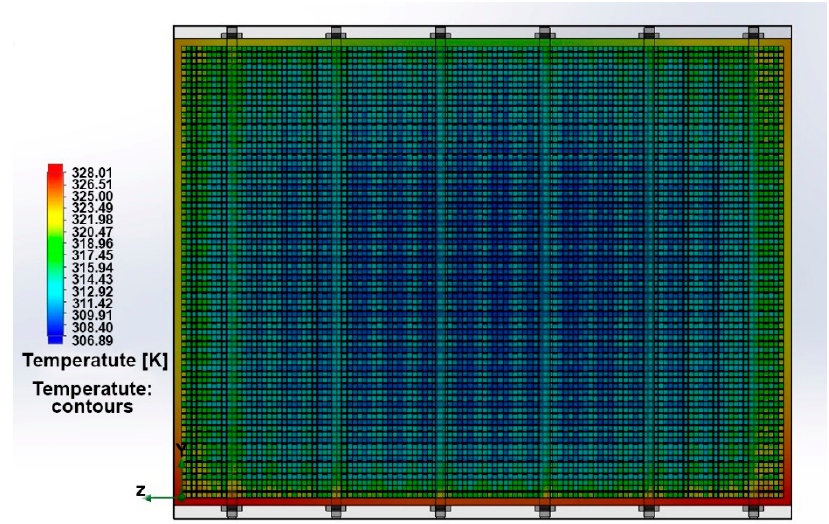
Figure 4. The distribution of temperature fields in PEMCF stack model.